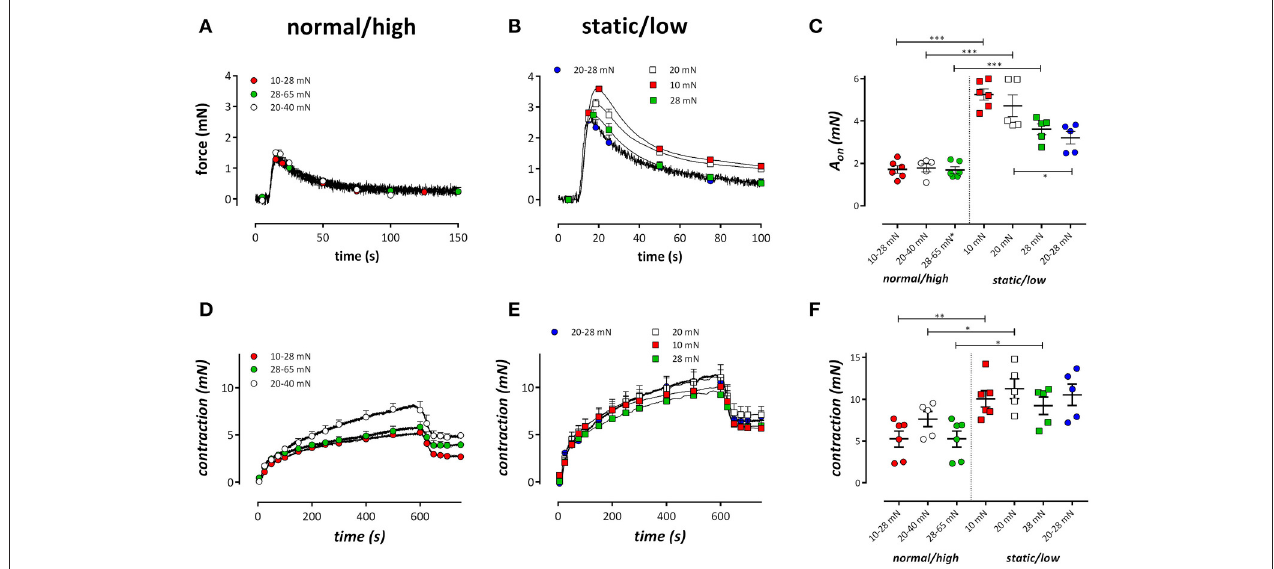
FIGURE 3 | Tonic and phasic contractions by 2 µ M PE. Tonic contractions by PE in the absence of external Ca 2 + in segments conditioned at cyclic stretch of 10–28 (red), 20–40 (white), or 28–65 (green)mN (A) or static stretch at 10 (red), 20 (white), or 28mN (blue) or low amplitude cyclic stretch at 20–28mN (blue). (C) Displays the amplitude of the contraction as revealed by a double exponential fit of the contractions. (D,E) Show the phasic contractions in the same conditions as (A,B) but after re-admission of extracellular Ca 2 + . At 600s, the VGCC blocker diltiazem (35 µ M) was added to determine the relative amount of VGCC-mediated Ca 2 + influx to the PE-induced tonic contraction. In (F) the contraction by PE after 600s is plotted for the different conditions. * P < 0.05, ** P < 0.01, *** P < 0.001 vs. corresponding static or low stretch conditions. One-way ANOVA with Dunnett’s multiple comparison test.